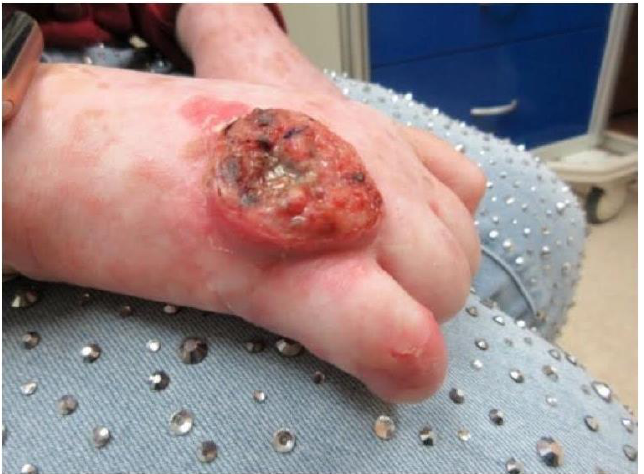
Figure 2. Right dorsal hand with 3.5 cm fungating, ulcerated, and slightly tender plaque with a pushing